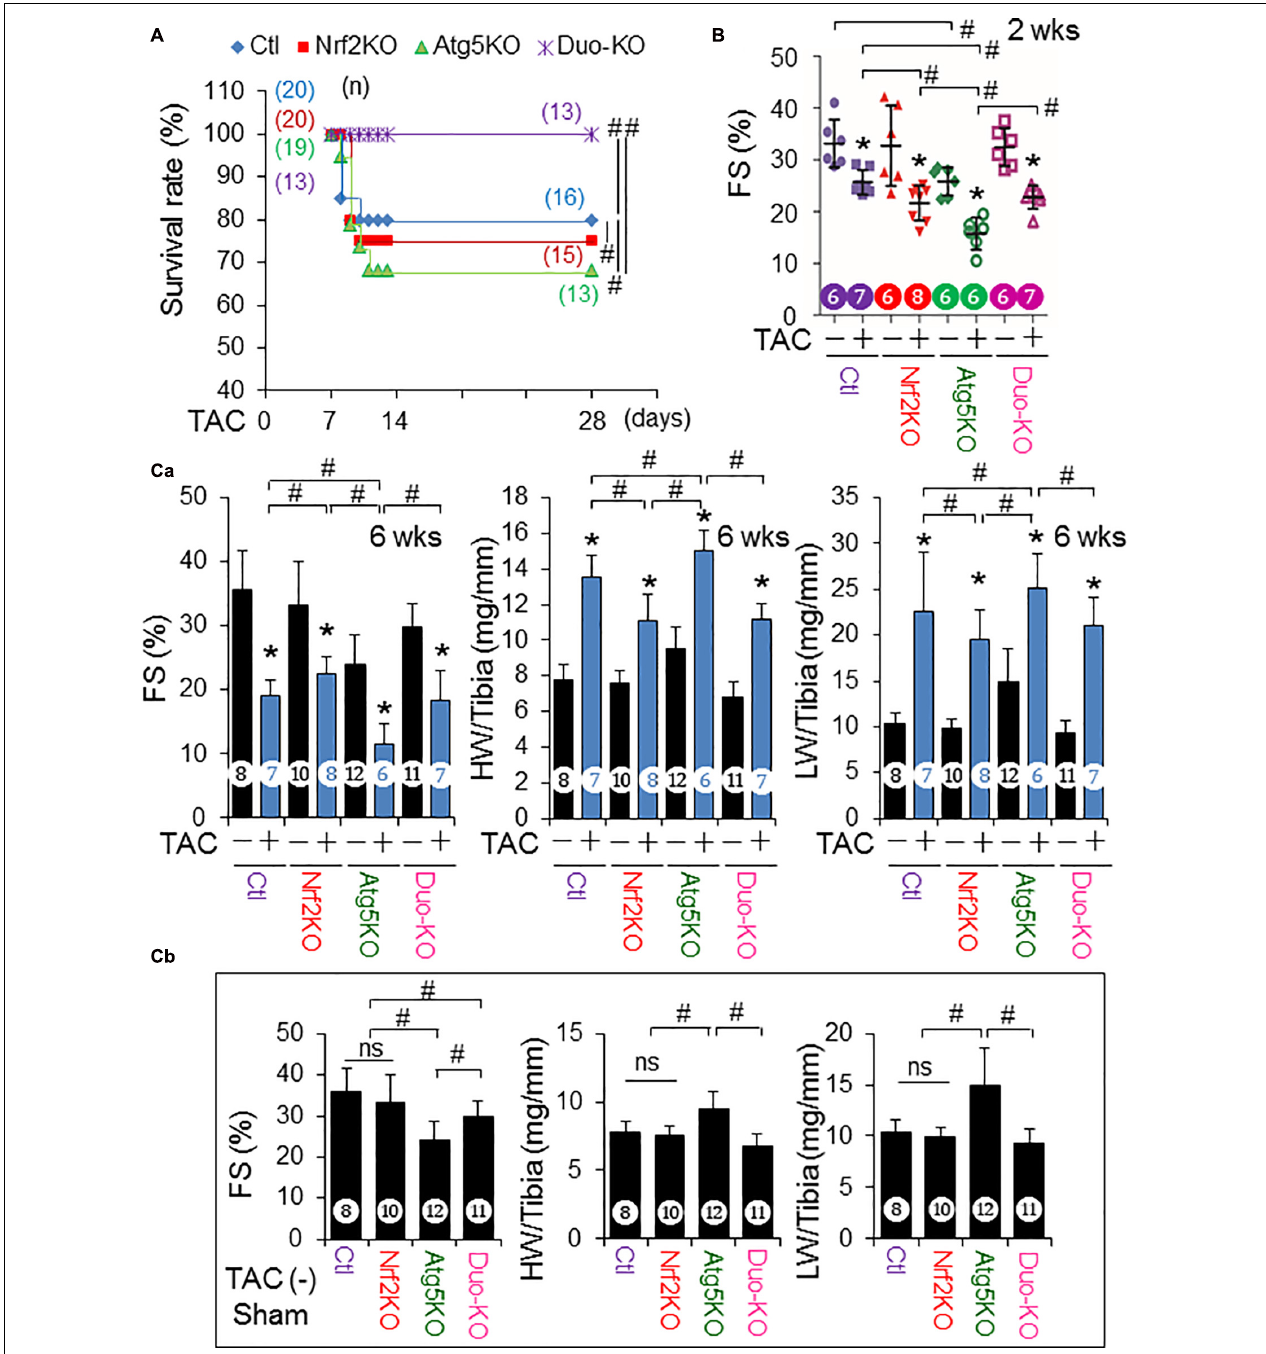
FIGURE 1 | Nrf2-mediated dichotomy in mice in response to pressure overload. The mice with genotypes of MerCreMer + (Ctl), MerCreMer + ::Nrf2 KO (Nrf2KO), MerCreMer + ::Atg5 fl / fl (Atg5KO), and MerCreMer + ::Atg5 fl / fl ::Nrf2KO (Duo-KO) received tamoxifen treatment as described in the section “Materials and Methods” and then were subject to sham and TAC operation for 6 weeks. (A) Survival rate at 4 weeks after TAC. # p < 0.05 by Kaplan Meier test. (B) FS (%) at 2 weeks after TAC. * p < 0.05 vs TAC (–) in the same groups using the Student t test; # p < 0.05 between indicated groups using one-way ANOVA followed by Bonferroni test. (C) FS (%), HW/Tibia ratio and LW/Tibia ratio at 6 weeks after TAC. * p < 0.05 vs TAC (–) in the same groups using the Student t test; # p < 0.05 between indicated groups using one-way ANOVA followed by Bonferroni test. (a) Statistic analysis of both sham and TAC groups; (b) Statistic analysis of sham groups alone. Animal number for each group is indicated in each figure. The efficacy of Cre and LoxP recombination which ablates myocardial Atg5 expression in Atg5KO and Duo-KO mice was confirmed by Western blot analysis.